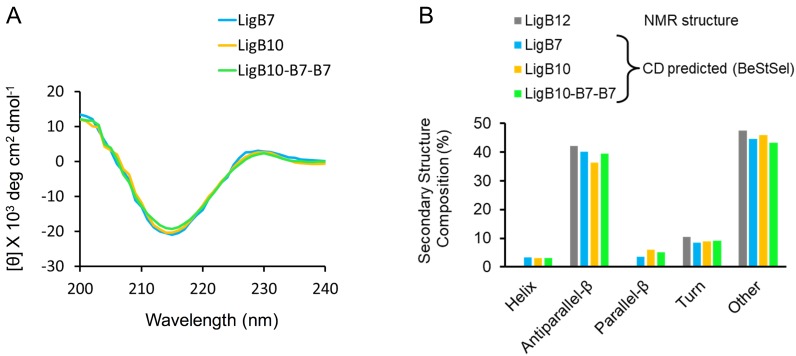
Secondary structure analysis for LigB Ig-like domains utilized in immunization trials.(A) Far-UV circular dichroism (CD) spectra were measured for LigB7, LigB10, and LigB10-B7-B7. The molar ellipticity, θ, was measured from 200 nm to 240 nm for 10 μM of each protein at room temperature. Mean values from three independent measurements were used to generate the spectra. (B) Using the experimental CD spectra, the secondary structure compositions for LigB7, LigB10, and LigB10-B7-B7 were predicted with the BeStSel webserver. The top Class, Architecture, and Topology predictions for all three LigB proteins were Mainly Beta, Sandwich, and Immunoglobulin-like, respectively. The BeStSel-derived secondary structure composition of LigB12 obtained from the NMR structure (PDB ID 2MOG) is reported for comparison.